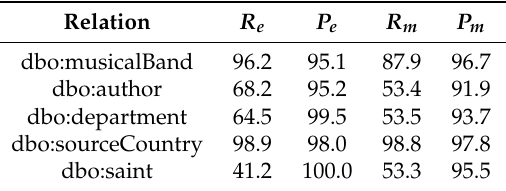
Table 6. Results of the manual verification of precision and recall scores computed on the existing relation instances. R e and P e denotes the recall and precision of the models computed on the existing relation instances, while R m and P m denotes those verified by manual